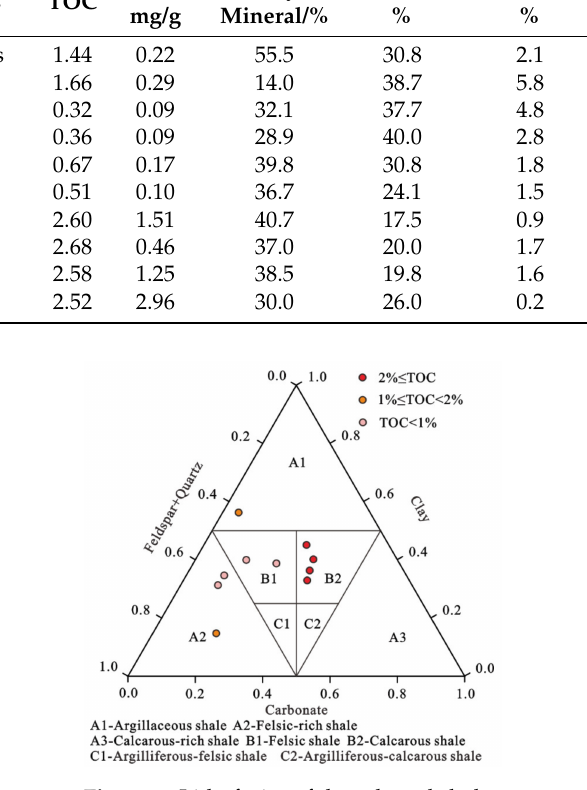
Figure 2. Lithofacies of the selected shales.